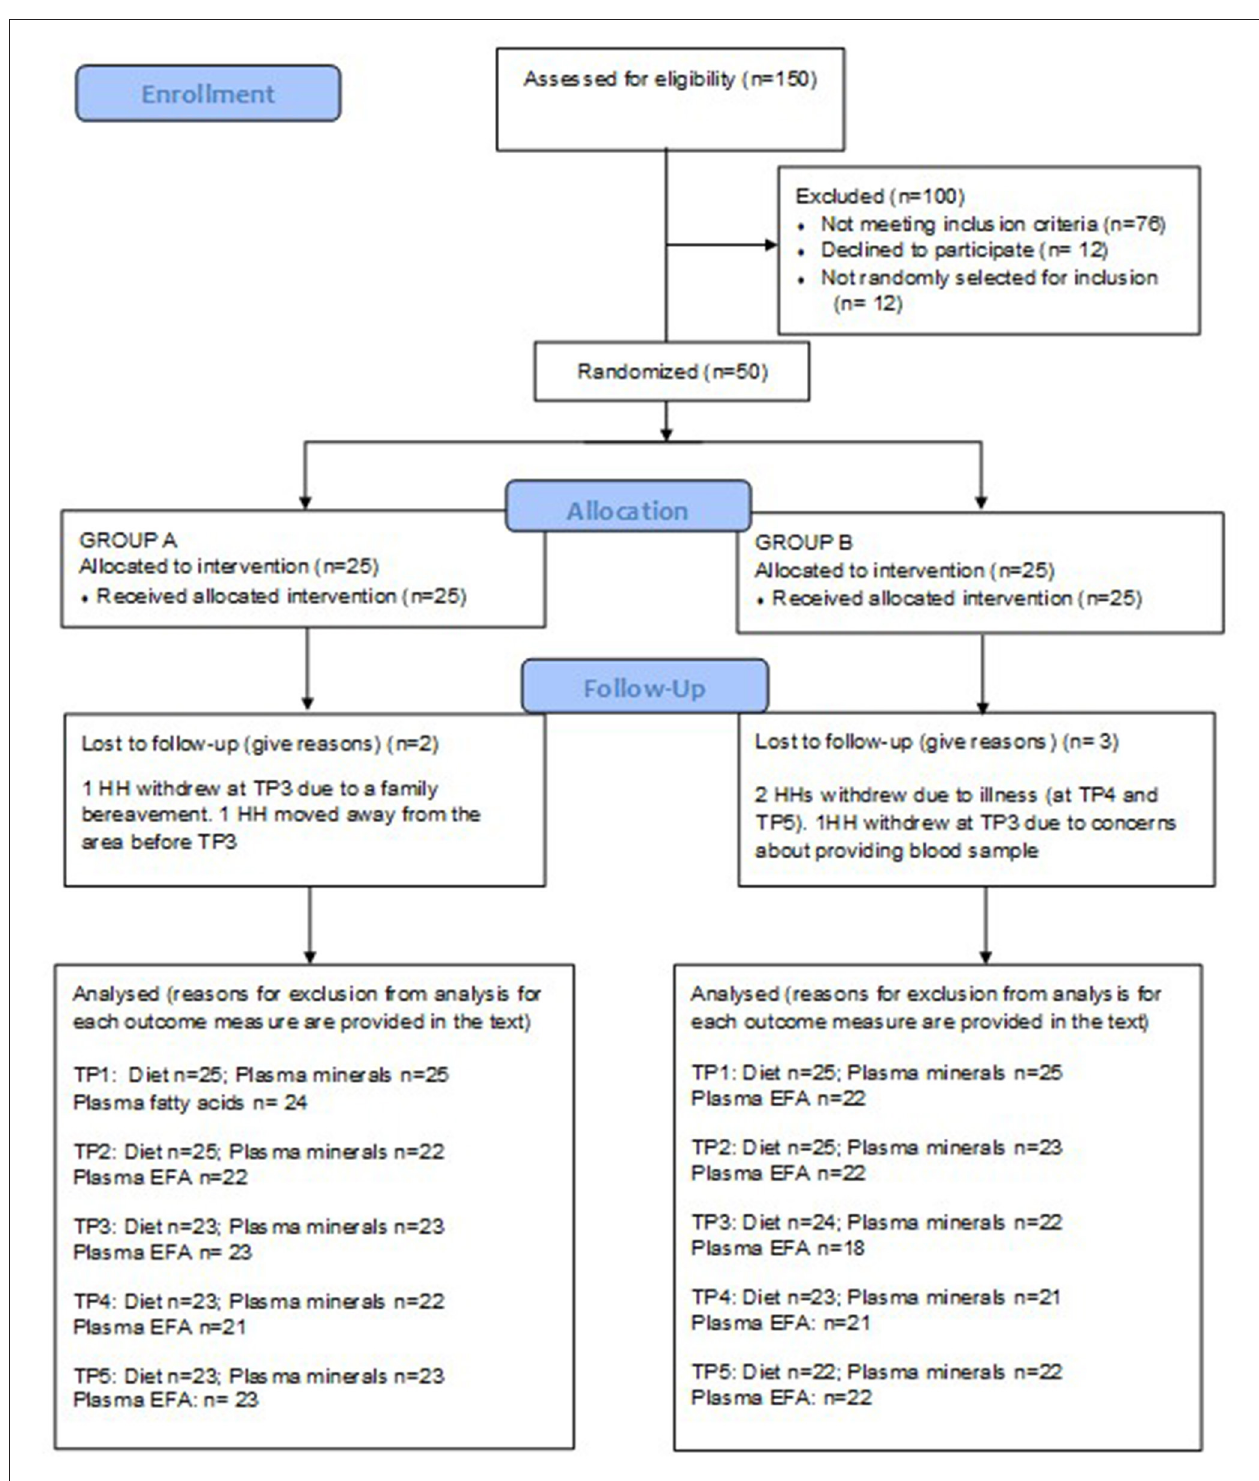
FIGURE 1 | CONSORT flow